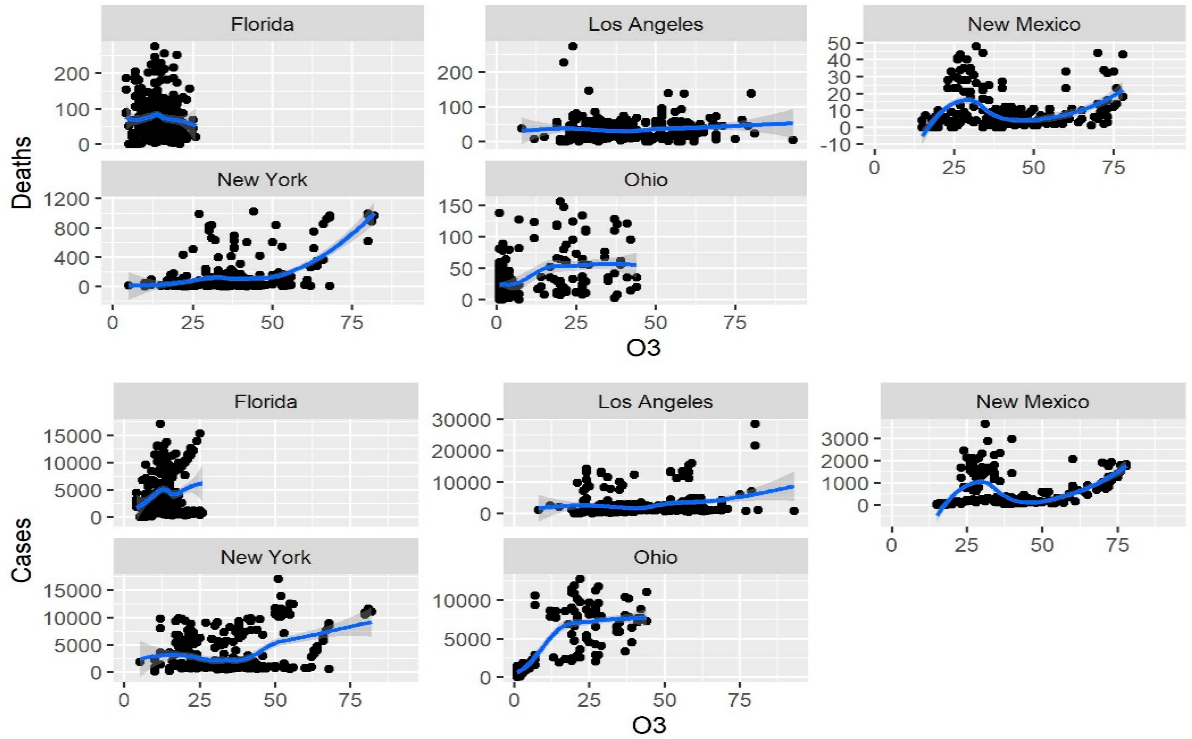
Figure 8. Relationship of the O 3 concentration with the number of new daily cases and deaths.